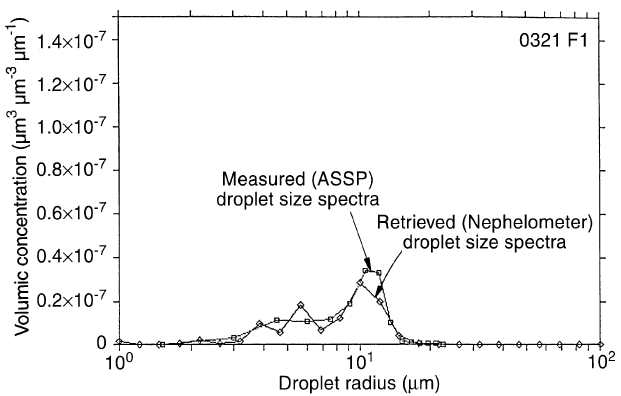
Fig. 8. Retrieved and ASSP measured droplet size distribution relative to cloudy conditions characterized by bimodal droplet size spectra Table 2. Comparison between direct and retrieved microphysical parameters (CONC: cloud droplet concentration, LWC: